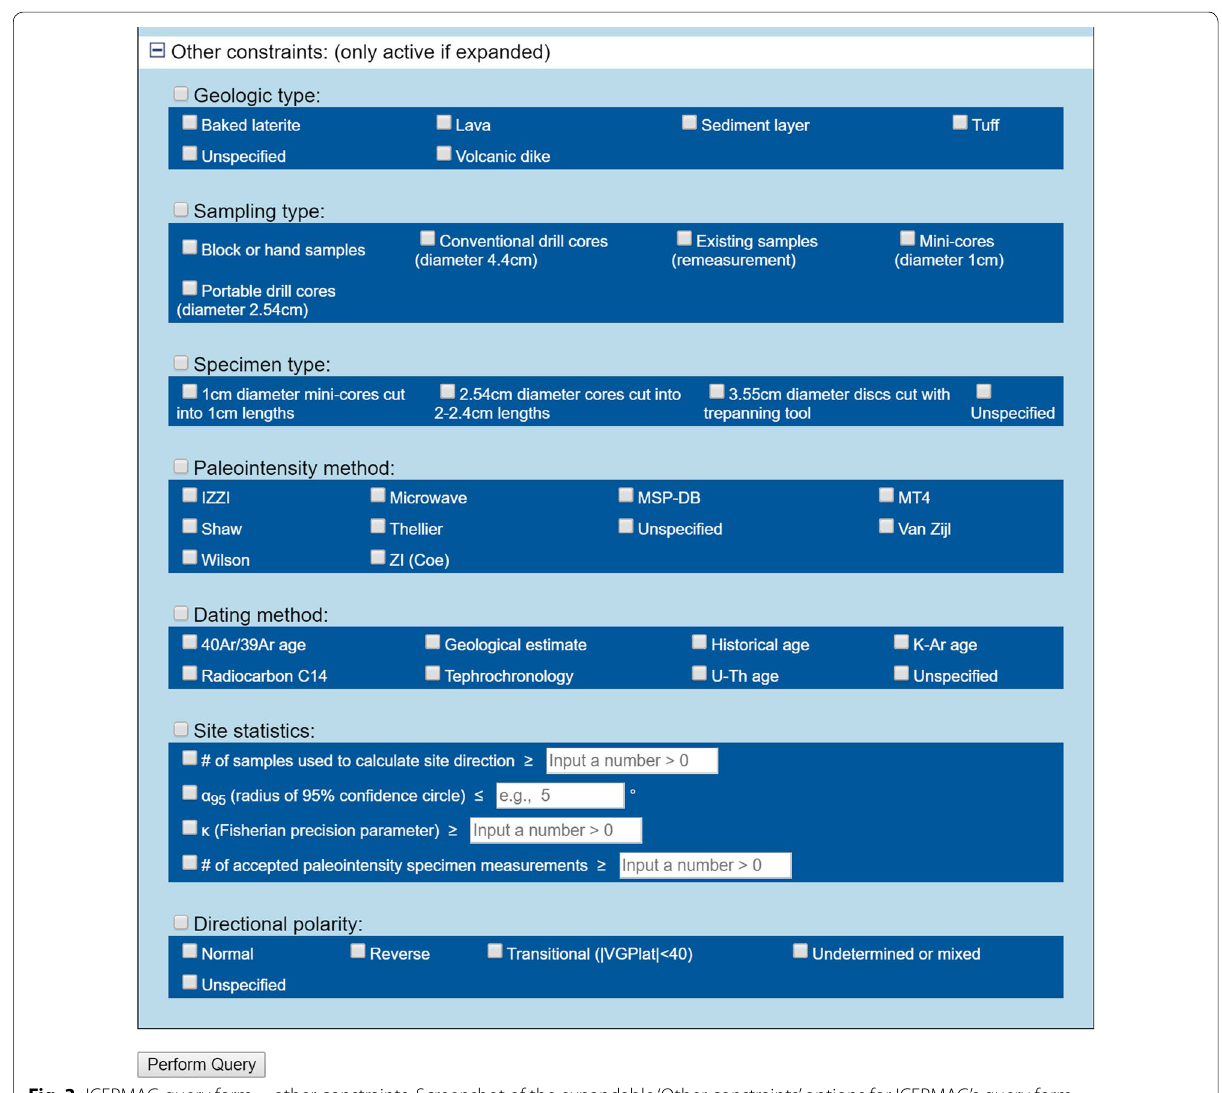
Fig. 3 ICEPMAG query form—other constraints. Screenshot of the expandable ‘Other constraints’ options for ICEPMAG’s query